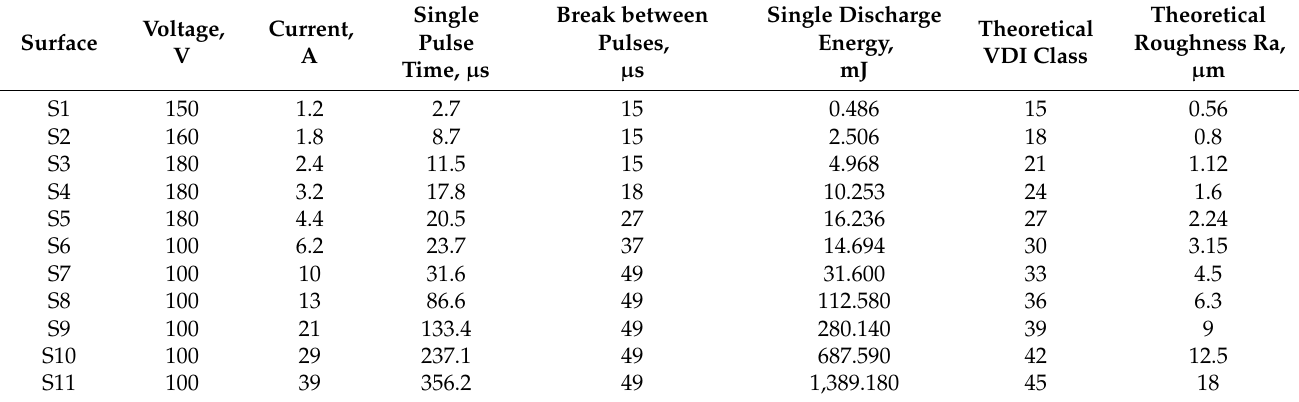
Table 2. Technological parameters used for the EDM of